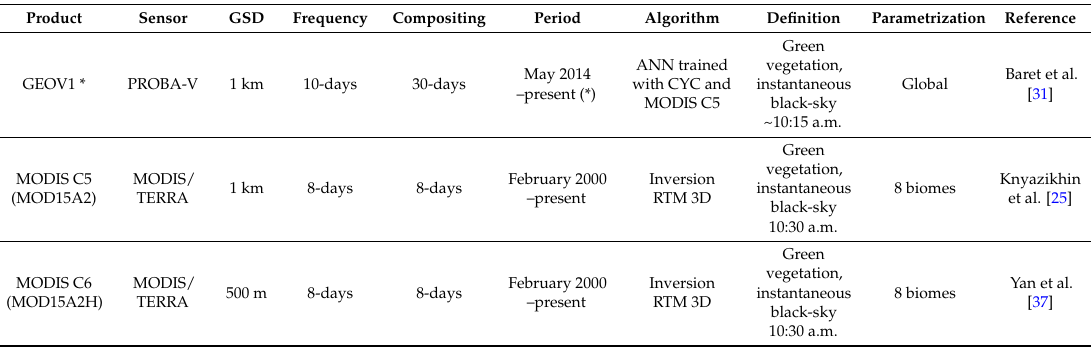
Table 1. Characteristics of the green fAPAR remote sensing products under study. GSD, ANN, RTM, and CYC stand for “Ground Sampling distance”, “Artificial Neural Network”, “Radiative Transfer Model”, and “CYCLOPES 3.1”,